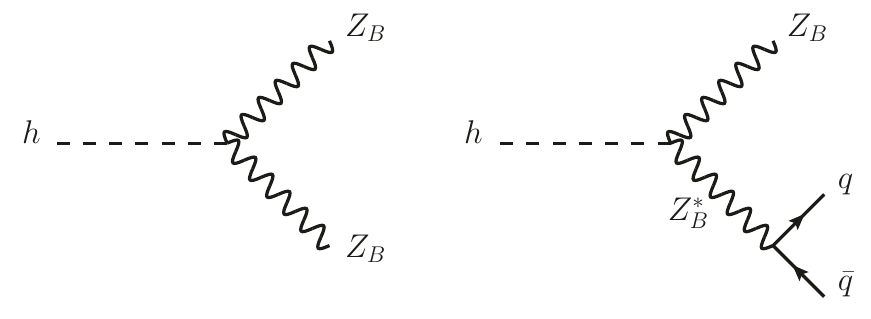
Figure 4 . Higgs decays into leptophobic gauge